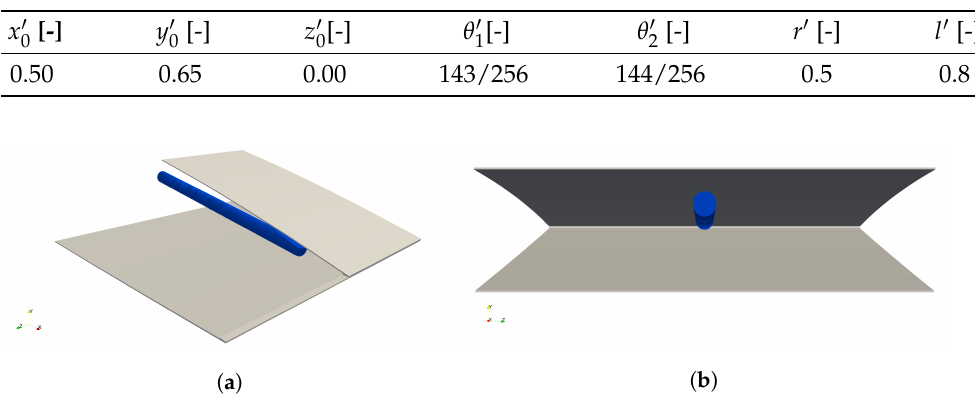
Table 3. Initial normalized ( (cid:48) ) design variables for the feature mapping approach.